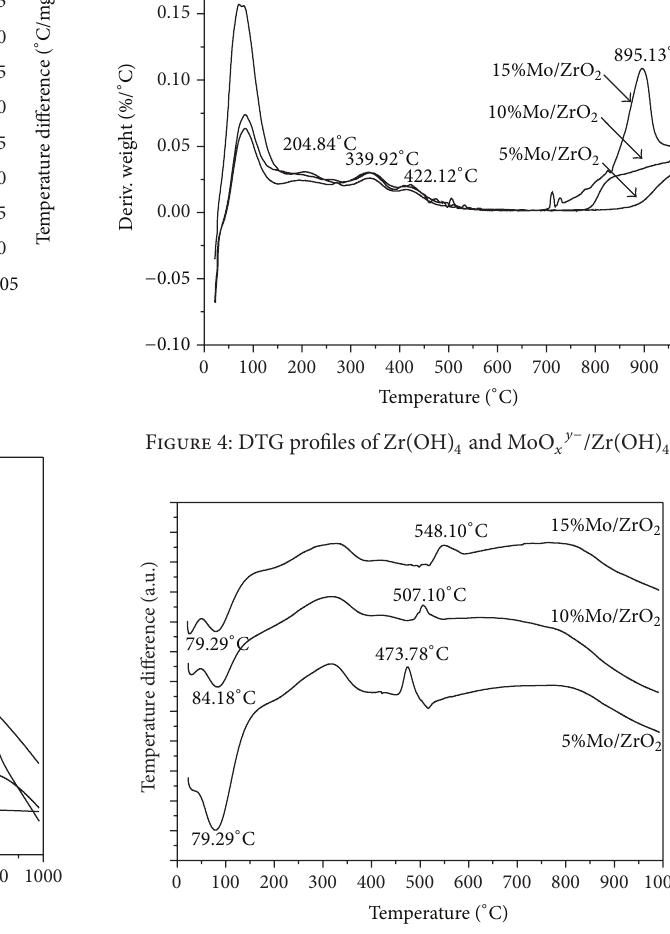
Figure 3: TGA profiles of Zr(OH) 4 and MoO 𝑥𝑦− /Zr(OH) 4 .